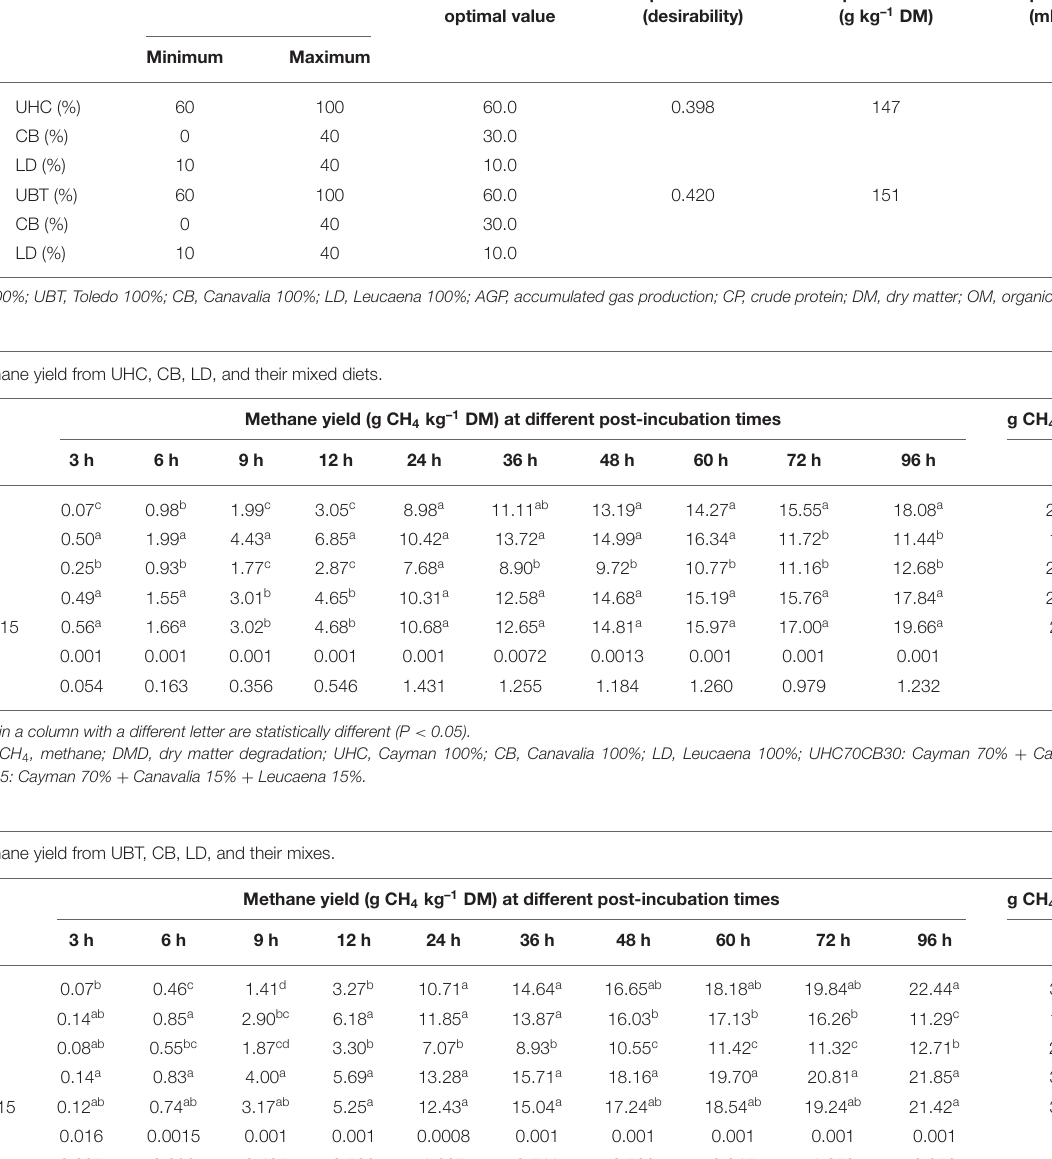
TABLE 6 | Optimization of the crude protein (CP; maximize) and accumulated gas production (AGP; minimize) response variables in the UHC and UBT forage systems. Systems